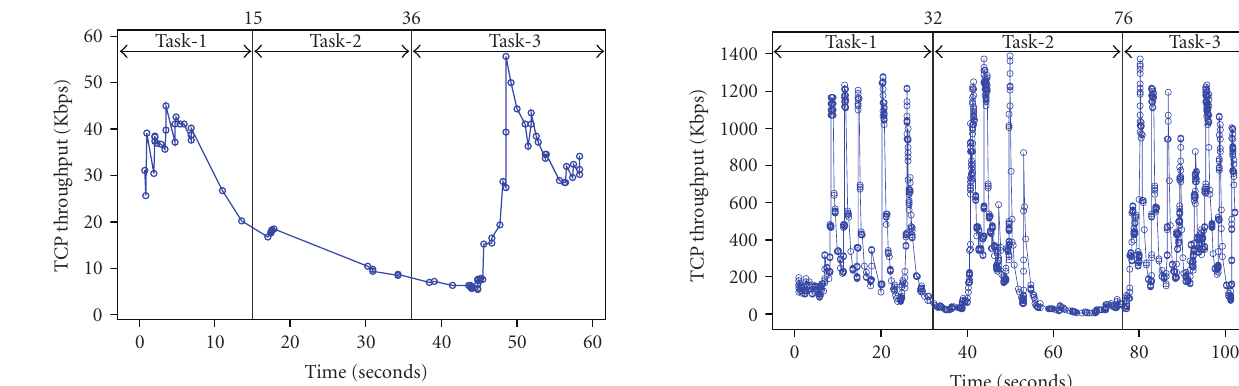
Figure 11: Control tra ffi c ( b in ) during an expert session on public LAN network connection.